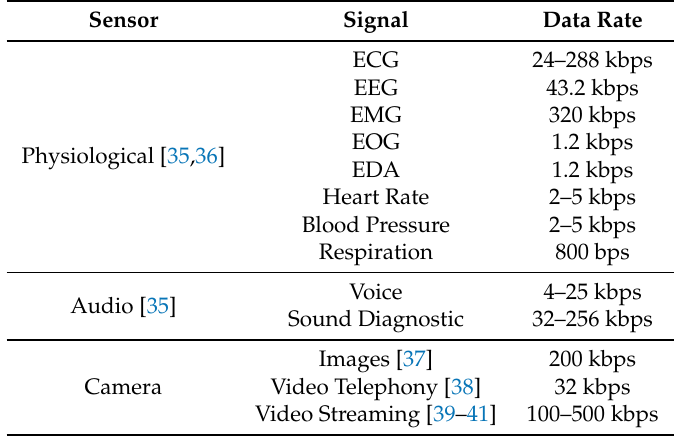
Table 1. Data rate requirements to enable remote monitoring applications for different